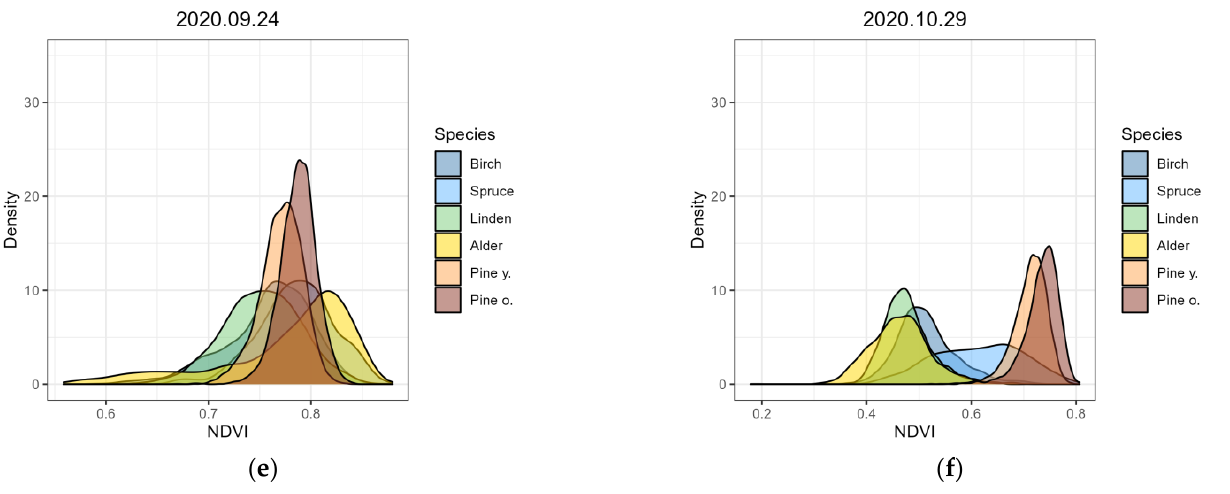
Figure 5. Histograms of the frequencies of NDVI values for different phenological dates: ( a ) 9 May